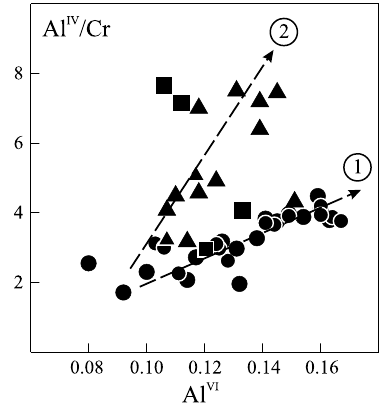
Fig. 10 – Variation in Al IV /Cr vs. Al VI for Group II clinopyroxenes from the Janjão, Pandolfo and Lambedor diatremes. 1 and 2: trend of clinopyroxenes thought to have been equilibrated in a mantle as- semblage where garnet was not present and with garnet, respectively. Symbols as in Fig.